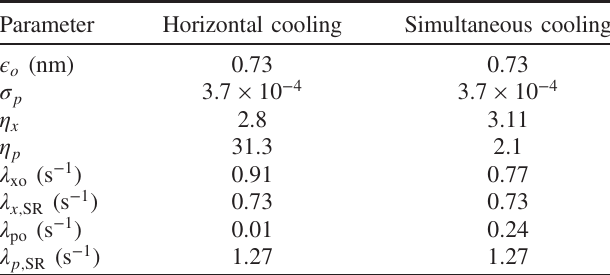
TABLE I. Major cooling parameters for the arc bypass in CESR.